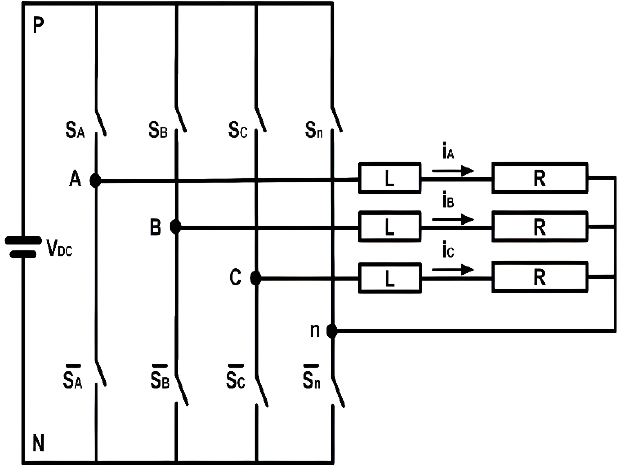
Figure 1. TP4LI Circuit.